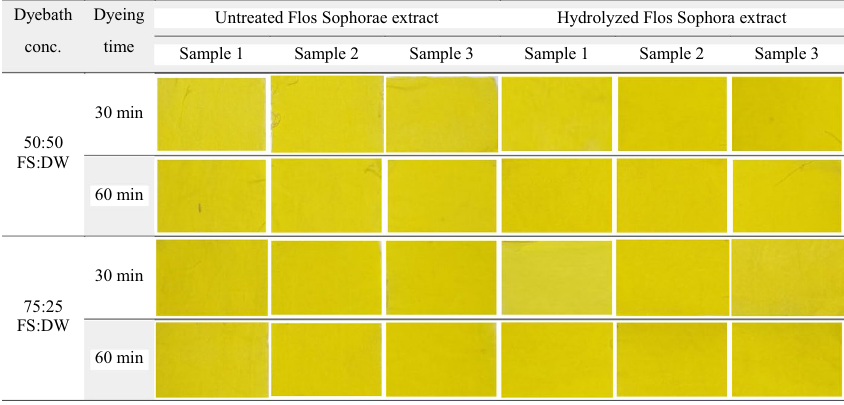
Table 8 Photographs of cotton dyed with untreated and hydrolyzed extract of Flos Sophorae Dyebath conc.